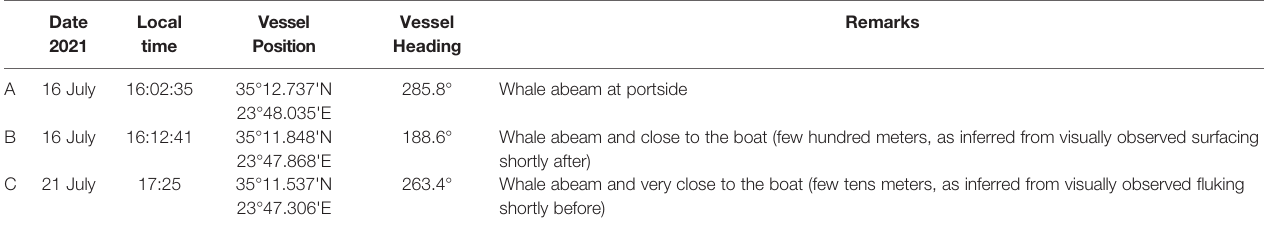
TABLE 1 | Vessel position and heading at the time of three acoustic observations using a towed two-hydrophone array during the 2021 veri fi cation